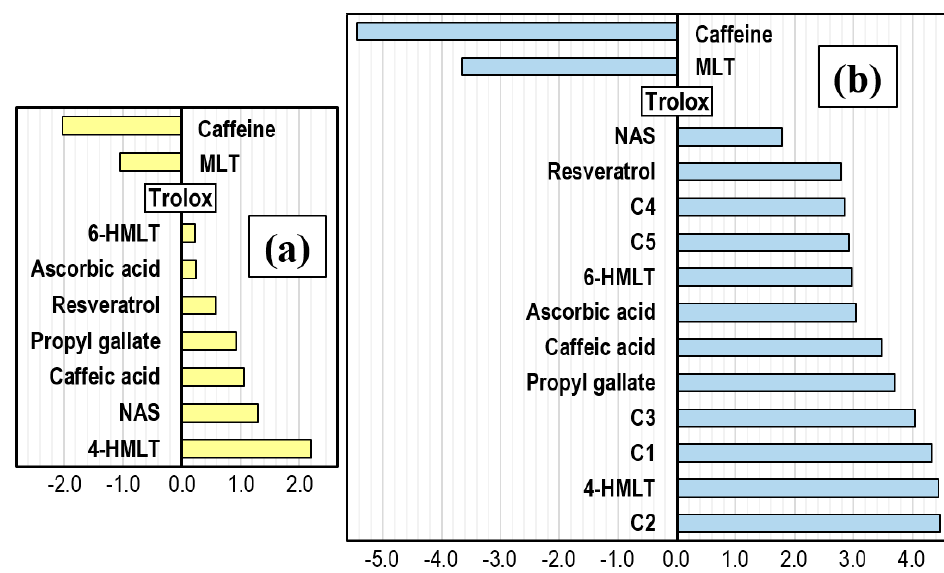
Figure 4. Relative rate constants ( k ) for the reactions with HOO • ( a ) in lipid solution; ( b ) in aqueous solution, at pH = 7.4. The x -axis values correspond to log( k i / k Trolox ). Data on Trolox, ascorbic acid, resveratrol, caffeine, propyl gallate, and caffeic acid was taken from references [120,173,263,272,292,456].